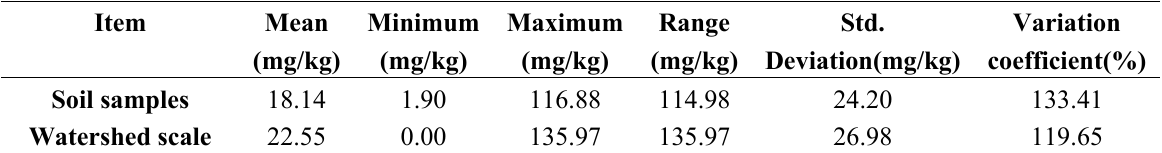
Table 4. Summary statistics of soil available phosphorus of soil samples and predicted